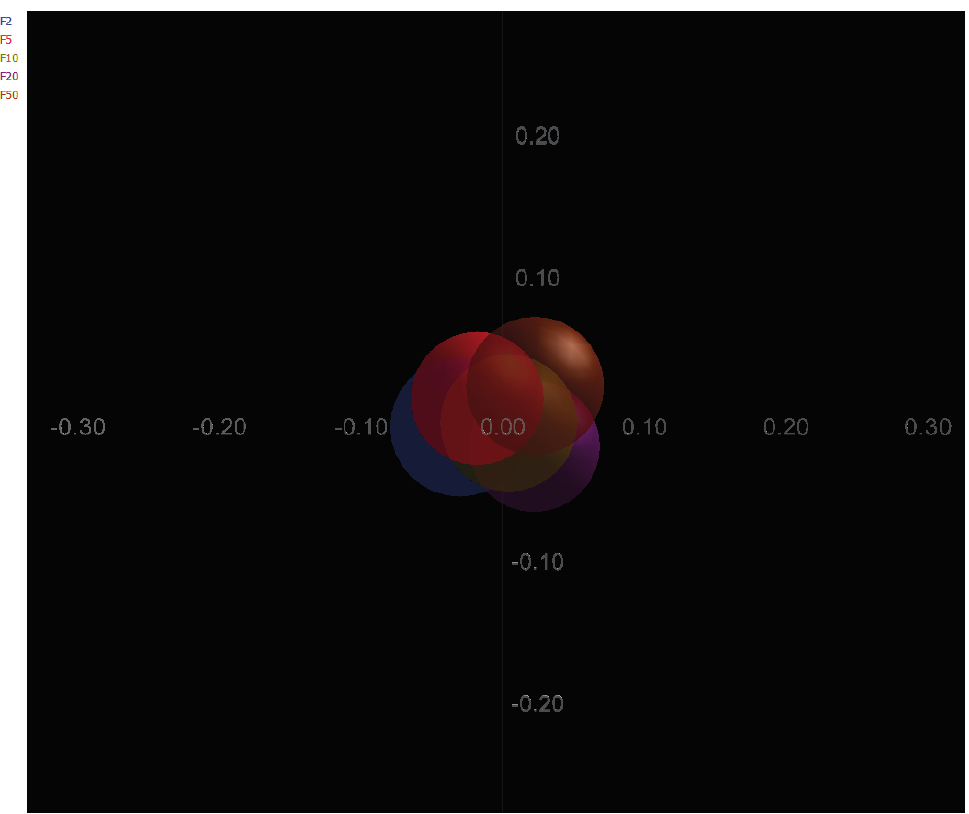
Figure 4. Principal Coordinates Analysis (PCoA) analysis of the microbiome of each currency note sample based upon beta div shannon 2d correlation. Different colored symbols are indicative of the various